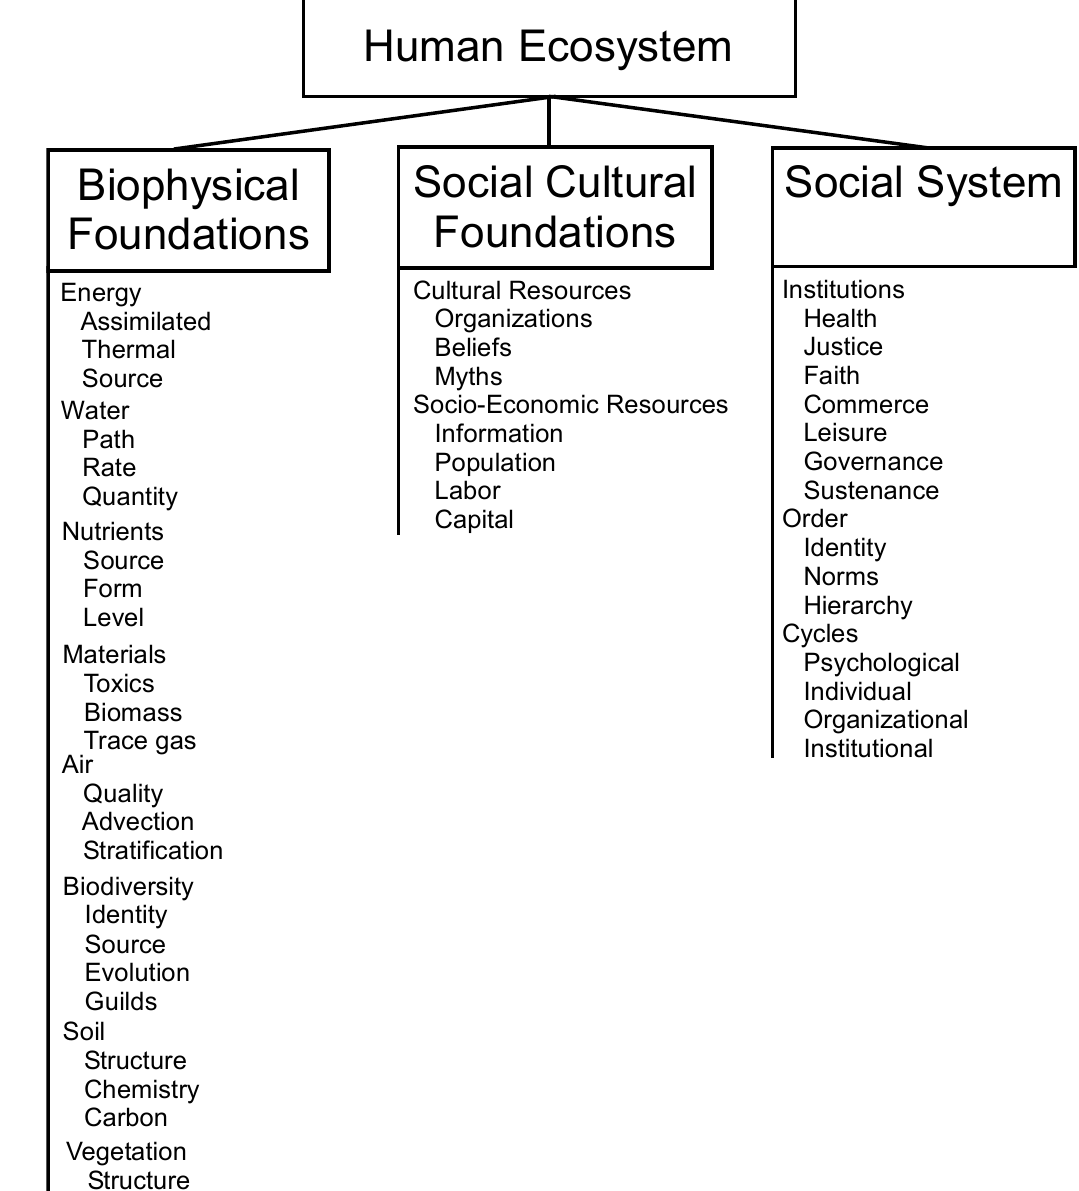
Figure 4. The human ecosystem framework as modified for use in the Baltimore Ecosystem Study, Long-Term Ecological Research project. Like the metamosaic concept, this is a nested hierarchy. Courtesy of